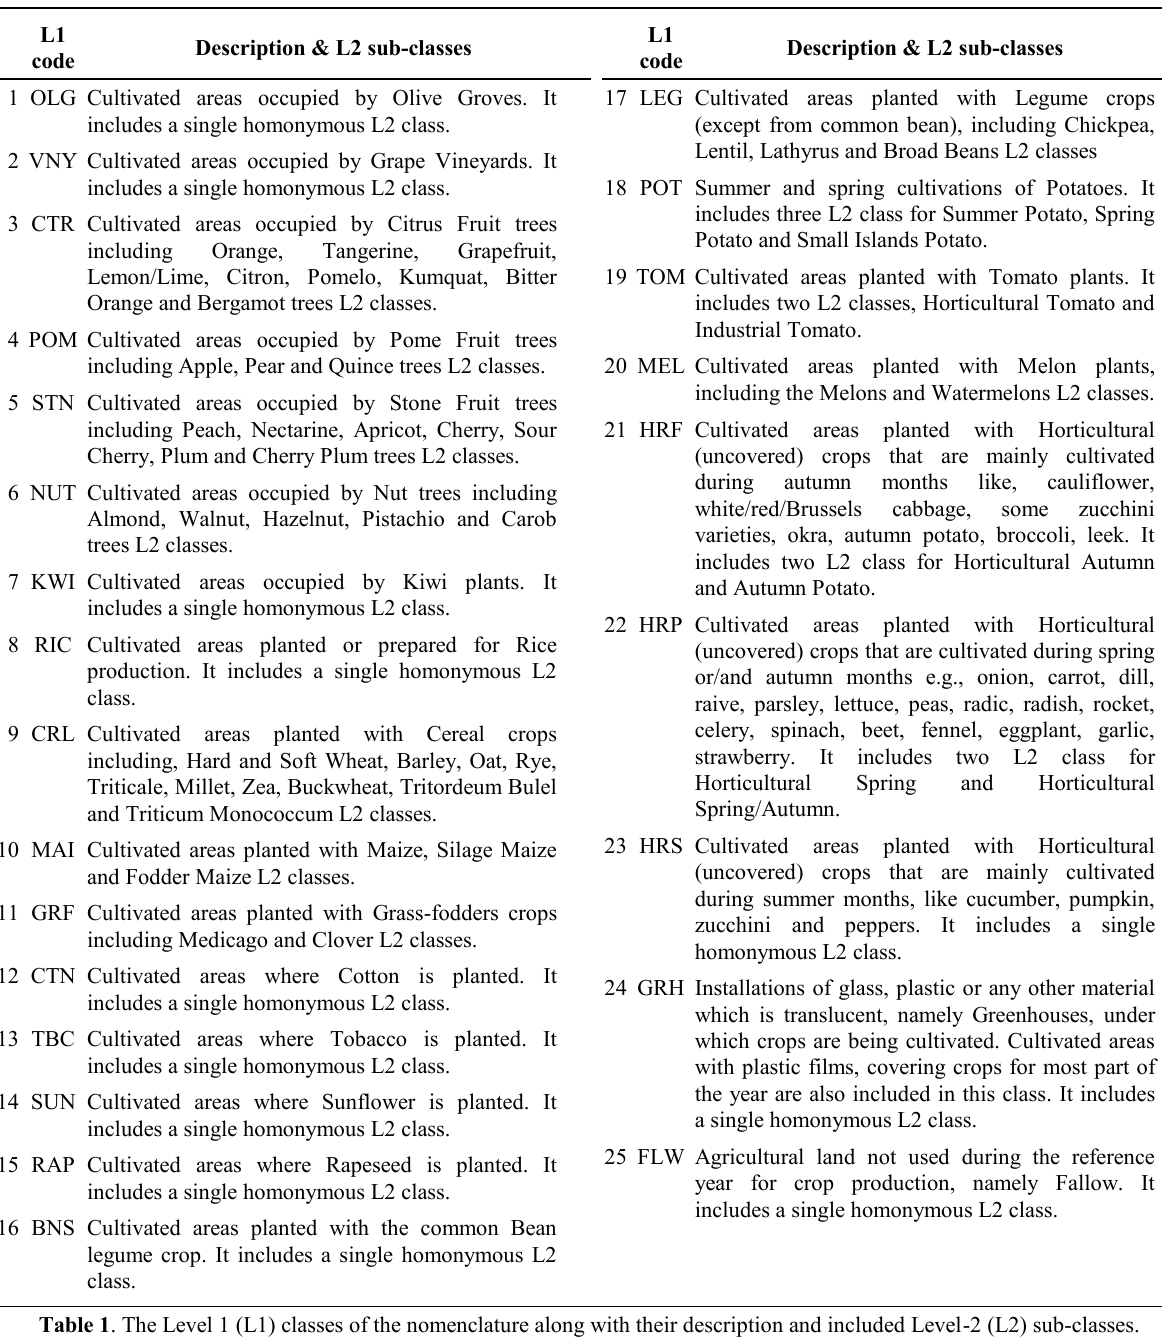
Table 1 . The Level 1 (L1) classes of the nomenclature along with their description and included Level-2 (L2)